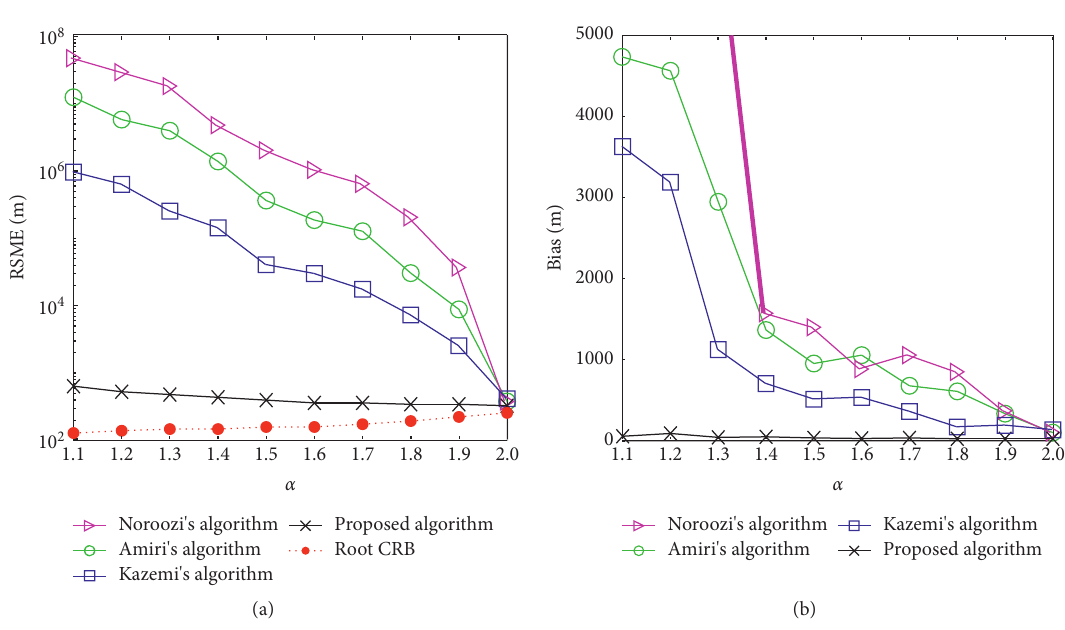
Figure 3: Localization (a) RMSE and (b) bias versus noise impulsiveness for different algorithms.